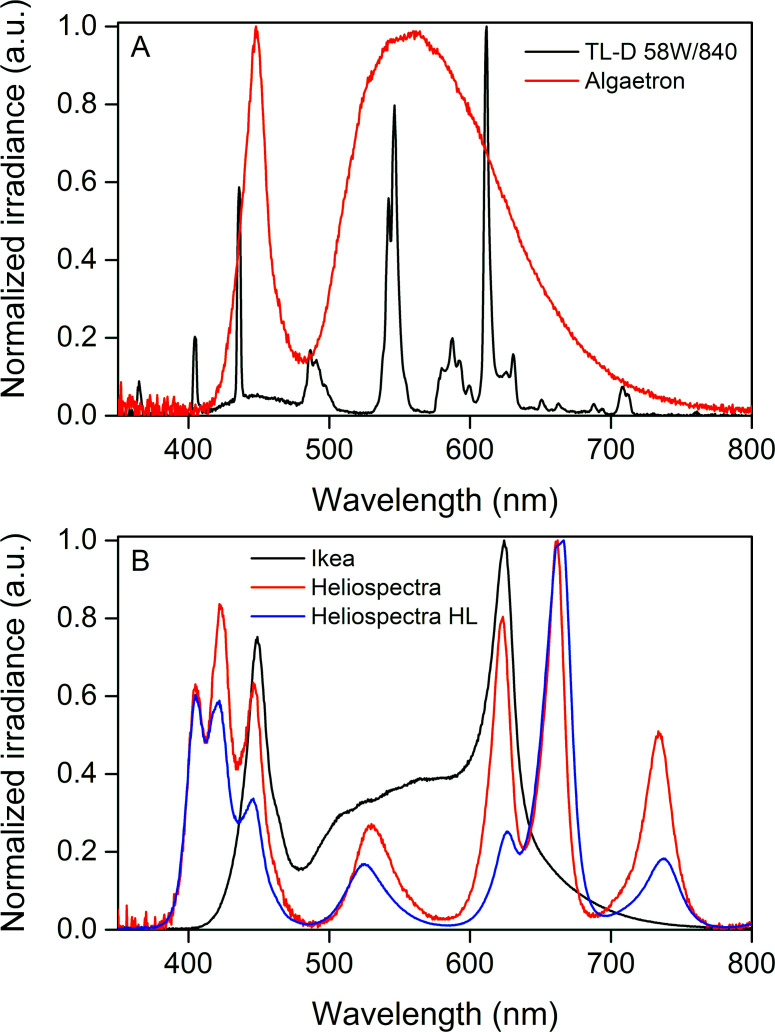
Normalized irradiance spectra from different light sources used in the study.(A) Growth light spectra, TL-D 58W/840 New Generation fluorescent tube (black) and Algaetron AG230 LED array (red), used as illumination in regular growth conditions and during acclimation to high CO2, respectively. (B) Light sources used in the starvation experiments: Ikea Växer PAR30 E27, 10 W (black) was used for the starvation experiment in steady light; Heliospectra L4A greenhouse lamp was used for the starvation experiment in fluctuating light, and the spectra are from moderate light conditions (PPFD 40 µmol m−2s−1; red) and during a high-light (HL) pulse (PPFD 1500 µmol m−2s−1; blue).